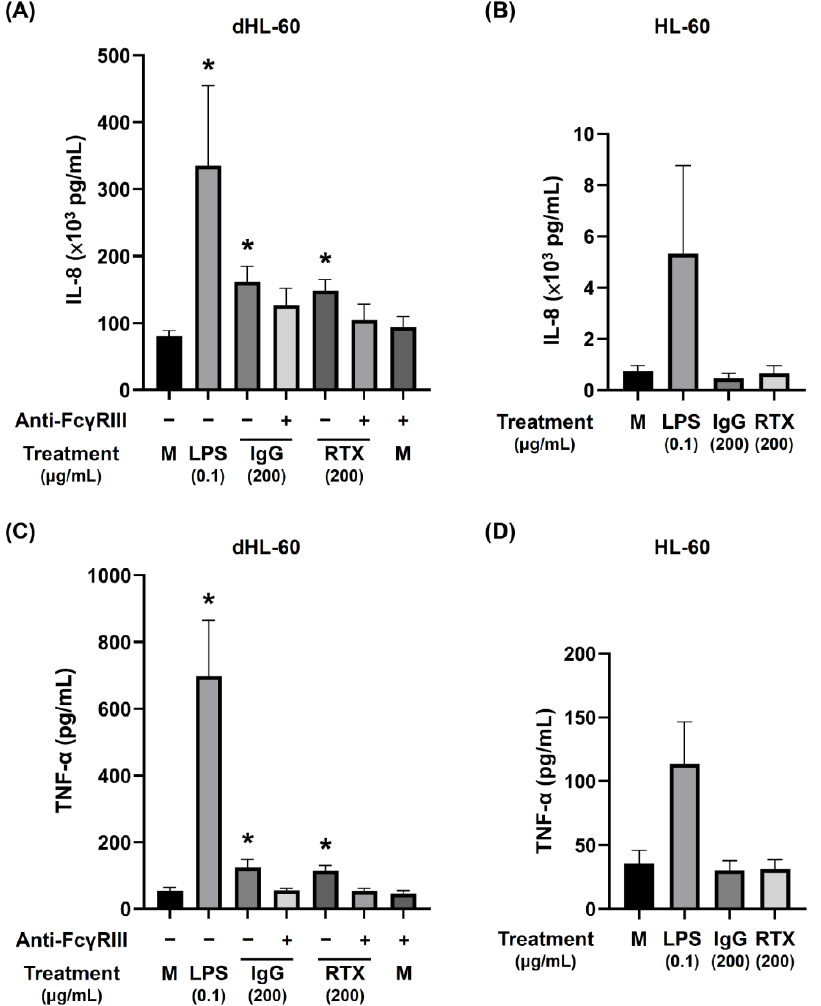
Figure 7. Increase in IL-8 and TNF- α production by dHL-60, but not by undifferentiated HL-60, after IgG and rituximab (RTX, IgG1 subclass) engagement. ( A ) Increased IL-8 production by dHL-60 cells after engagement by IgG and RTX that can be abolished by anti-Fc γ RIII antibody (1 µ g/mL). ( B ) No increased IL-8 production by undifferentiated HL-60 cells. ( C ) Increased TNF- α production by dHL-60 cells after engagement by IgG and RTX that can be abolished by anti-Fc γ RIII antibody (1 µ g/mL). ( D ) TNF- α production by undifferentiated HL-60 cells. * p < 0.05 compare to medium control